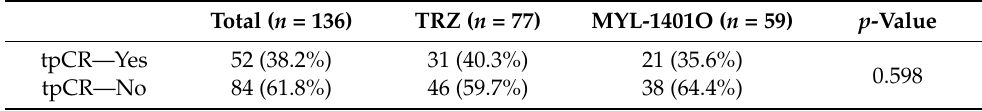
Table 4. Univariate analysis for tpCR by trastuzumab product.